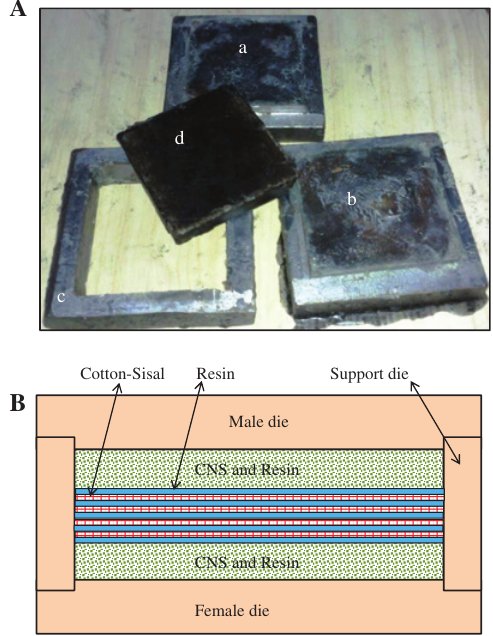
Figure 4: (A) Split type steel mould for composite preparation: (a) male die, (b) female die, (c) support die, and (d) composite plate; and (B) schematic diagram of the composite fabrication